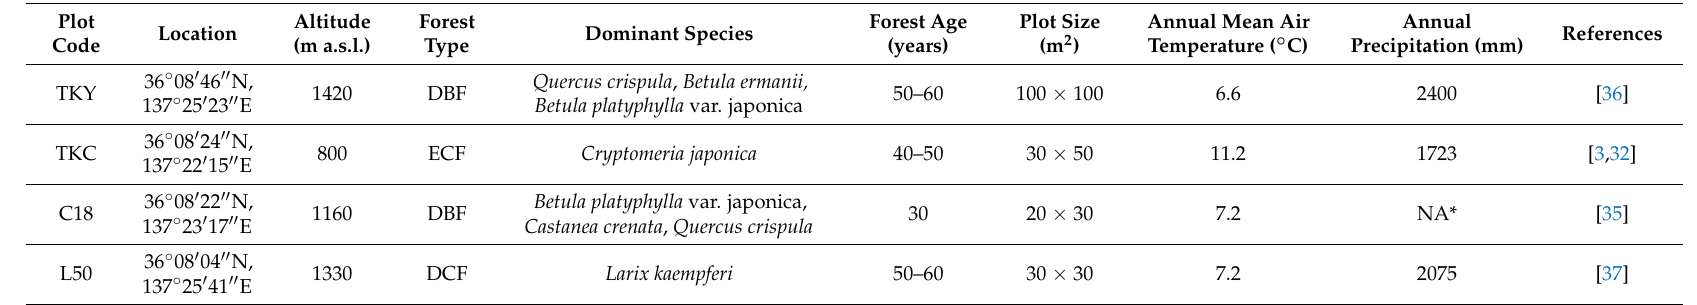
Table 1. Information about the four study